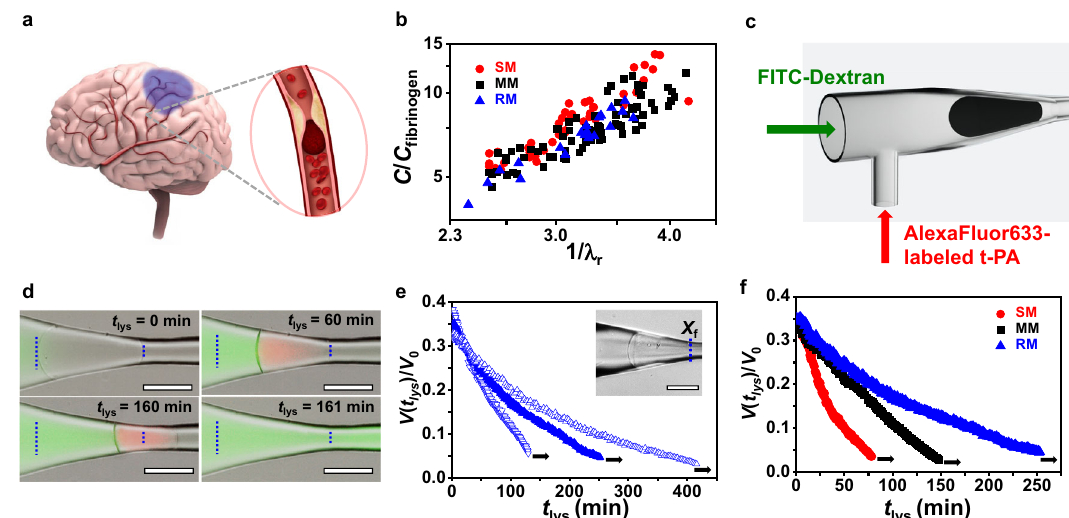
Fig. 3 Lysis of occlusive fi brin microgels. a Schematic of occlusion of a cerebral artery in the brain. b Con fi nement-mediated relative increase in fi brin concentration in obstructive SMs (red solid circles), MMs (black solid squares), and RMs (blue solid triangles). c Experimental design used for studies of lysis of the con fi ned fi brin gel. A solution of fl uorescently labeled tPA in TBS was infused at a fl ow rate of 5.6 × 10 7 μ m 3 /s and an additional pressure difference of 0.7 Pa from a channel placed orthogonally to the long axis of the main microchannel. d Merged multi-channel microscopy images of an obstructive MM ( D 0 = 200 μ m) positioned at X f = 28 μ m at Δ P = 700 Pa and subjected to digestion. Vertical dashed lines show the original positions of the back and front MM edges at t lys = 0. Green and pink colors correspond to FITC-Dextran (70 kDa) and AlexaFluor633-labeled tPA, respectively. e Temporal variation in the relative volume of occlusive RM with D 0 of 174 μ m (blue hollow inverted triangles), 199 μ m (blue triangles), and 218 μ m (blue hollow triangles), respectively, placed at X f = 28 ± 1 μ m in the tapered microchannel region at Δ P of 1200, 1800, and 3000 Pa, respectively, and Q = 1860 ± 70 μ m 3 /s. Inset shows RM ( D 0 = 218 μ m) blocking the microchannel. f Temporal variation in the relative volume of SM, MM, or RM ( D 0 = 197 ± 3 μ m) placed at X f = 32 ± 12 μ m in the tapered microchannel zone at Δ P of 400, 750, and 1800 Pa and Q of 12300, 2400, and 1860 μ m 3 /s, respectively. X f is the front edge position of the microgel determined its distance from the beginning of the constriction. V ( t lys ) and V 0 is temporal volume of lysed microgel and the volume of the unperturbed microgel, respectively. The colors of symbols correspond to those in b . The black arrows in e , f correspond to the last time point before the microgel passed the microchannel. Scale bars in d , e are 100 μ